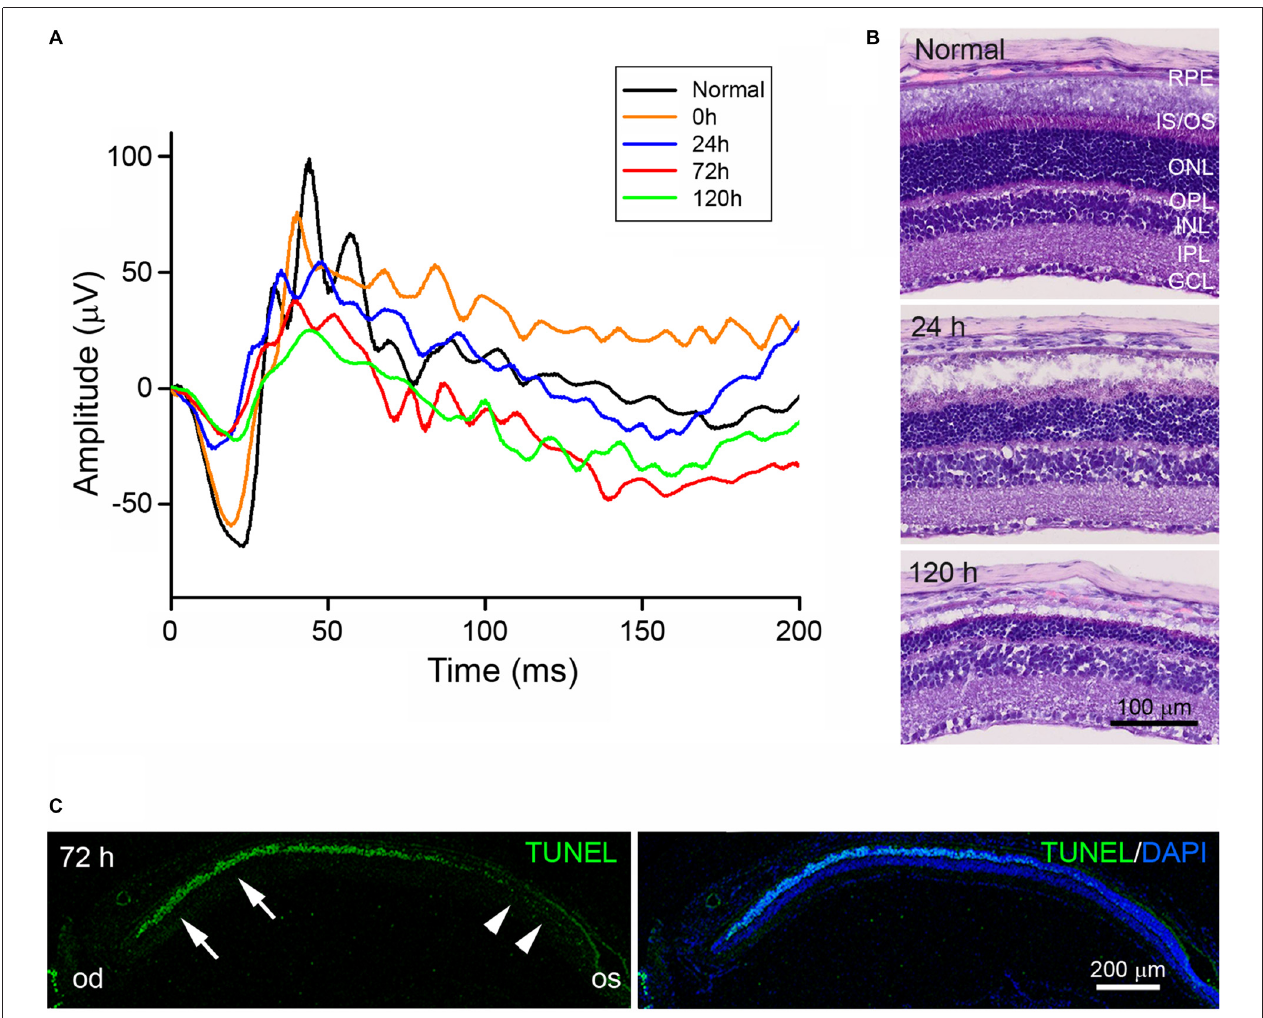
FIGURE 1 | Characterization of blue light-emitting diode (LED)-induced retinal degeneration (RD) in mice. (A) Representative scotopic electroretinography (ERG) responses in unexposed control (black) and blue LED-induced retinas at 0 (orange), 24 (blue), 72 (red), and 120 h (green). All ERG components showed progressive reductions in a time-dependent manner. (B) Hematoxylin and Eosin (H&E) staining of representative retinal tissue sections. Consistent with ERG findings, retinal thickness decreased in a time-dependent manner. Prominent decreases were observed in the outer nuclear layer (ONL). GCL, ganglion cell layer; INL, inner nuclear layer; IPL, inner plexiform layer; IS/OS, inner segment and outer segment; OPL, outer plexiform layer; RPE, retinal pigment epithelium. (C) Terminal deoxynucleotidyl transferase dutp nick end labeling (TUNEL) staining on a vertical section of eyecup taken from an RD mouse at 72 h after blue LED exposure. Numerous TUNEL-positive photoreceptors were observed in the ONL of the central retina (arrows) near the optic disc (od), while few TUNEL-positive cells were observed in the peripheral retina (arrowheads) near the ora serrata (os). 4 (cid:48) ,6-diamidino-2 (cid:48) -phenylindole (DAPI) staining was used to label the nuclei of retinal cells.